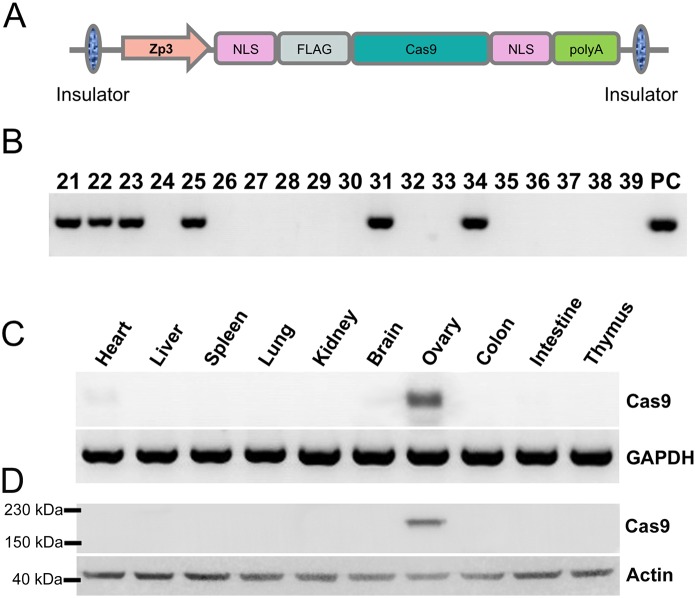
Generating a oocyte-specific Cas9 transgenic mouse line.(A) A schematic representation of the vector expressing Cas9 in oocyte. The Zp3-Cas9 plasmid encodes the Cas9 under the regulation of a 2 kb Zp3 promoter. Two nuclear localization signals (NLSs) were inserted into N and C terminals of Cas9. (B) Six transgenic founders from total 39 F0 were identified by Cas9 gene amplification by PCR. PC, positive control. (#21, #22, #23 are germ-line heritable). (C and D) RT-PCR and Western blotting confirmed the ovary specific expression of Cas9 in Zp3-Cas9 transgenic mouse.